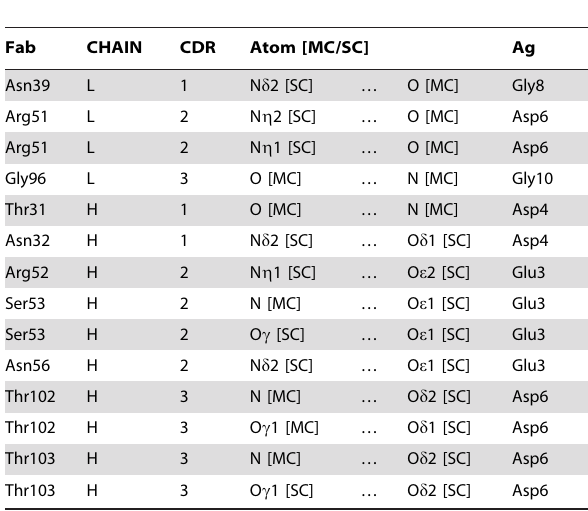
Figure 2. Structure of the Fab17.2 – R13 complex. A. Superposition of the apo Fab 17.2 and R13 complex structures (grey and green respectively). VH and VL contact residues are indicated. B. Main water molecules present on the antigen binding site of Fab 17.2 apo. C. Superposition of water molecules present in the apo Fab 17.2 that are replaced by the peptide in the Fab 17.2 R13 complex. D. Superposition of R13 peptides from molecules 1 (green) and 2 (magenta). E. Structure of the Fab 17.2-R13 complex (molecule 1). All hydrogen bonds between mAb 17.2 and peptide R13 are illustrated as dotted yellow lines. The p -stacking interaction between VL Tyr101 and the epitope Phe9 is also indicated. Heavy chain CDRs are coloured in red and light chain CDRs in blue the peptide is coloured in light green. doi:10.1371/journal.pntd.0001375.g002 Table 2. Polar contacts between Fab 17.2 and R13